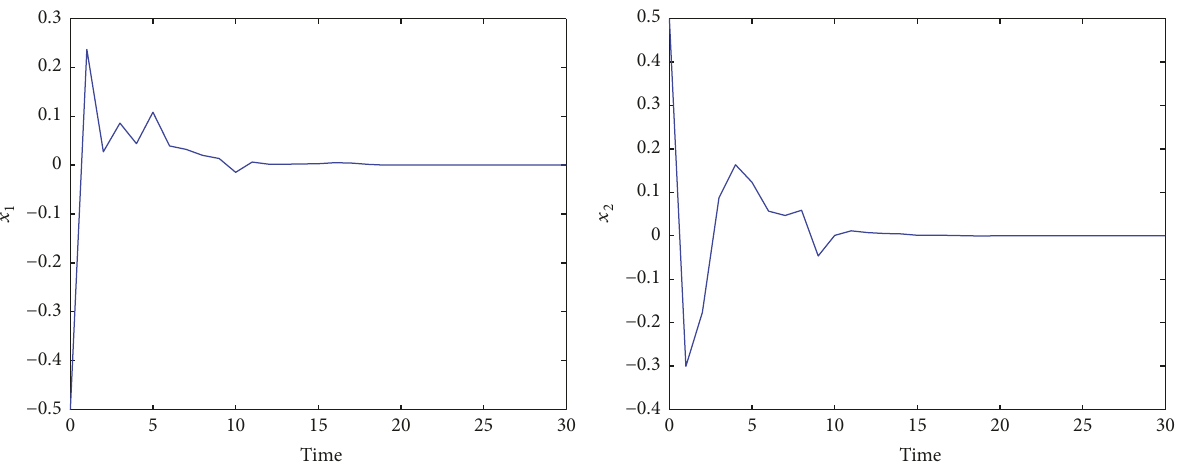
Figure 3: The states of closed-loop system for Example